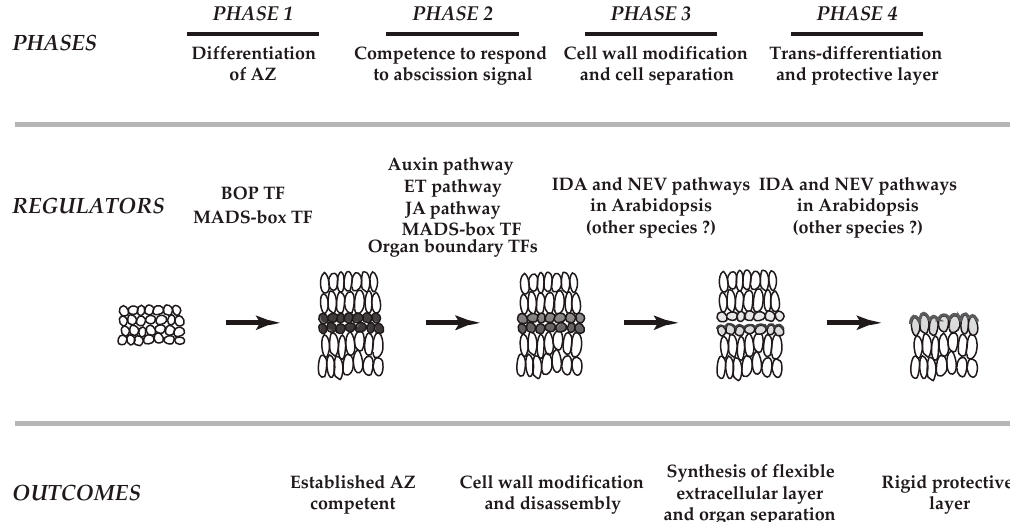
model of organ separation (Figure 1) [2,7,12].